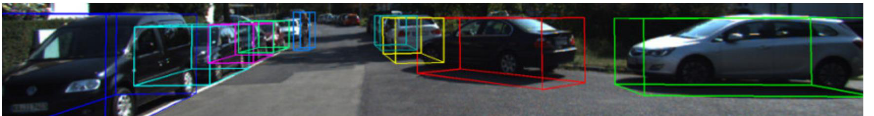
Figure 4. KITTI 3D object detection benchmark